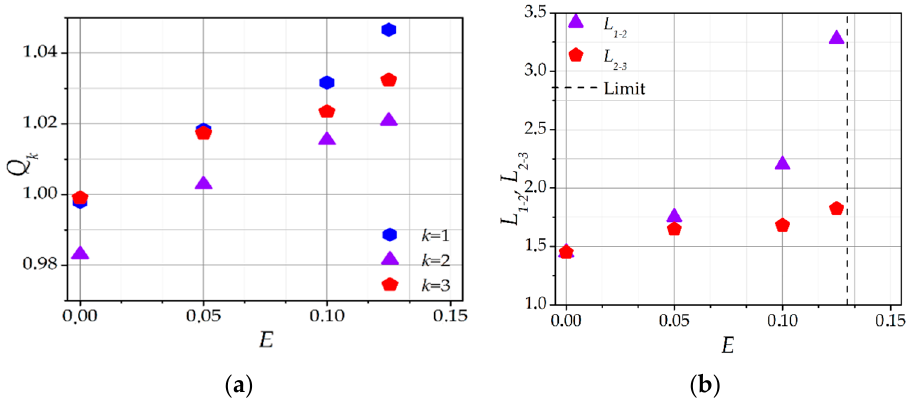
Figure 6. Dependence of the ( a ) self-consistent dust particle charges Q k , and ( b ) equilibrium interparticle distances L 1-2 and L 2-3 between the dust particles in a chain on the external electric field E . F ext = − 0.2, l i =5.